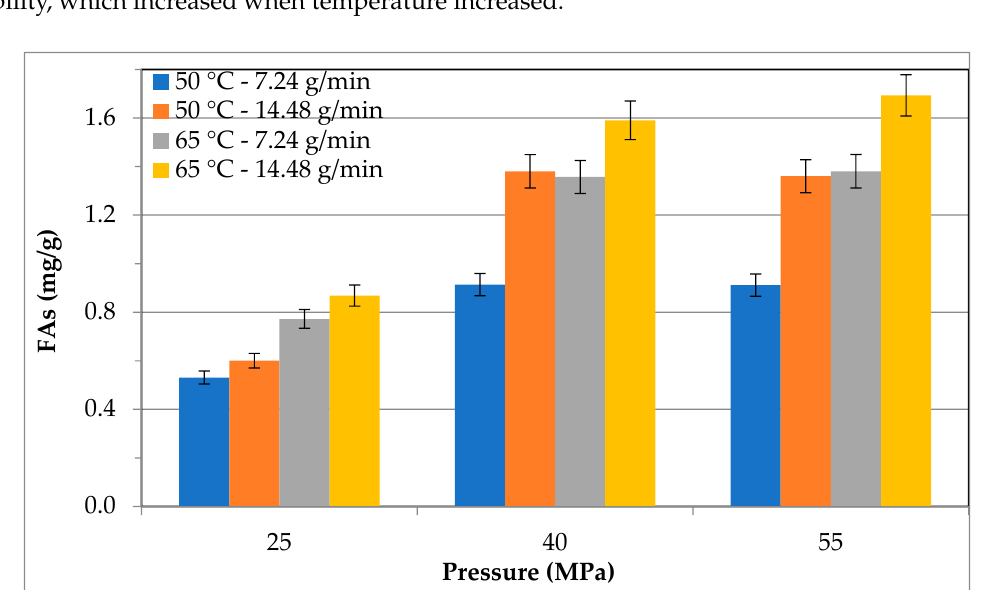
Table 2. Effect of SF-CO 2 operating conditions on fatty acids from S. almeriensis -pretreated biomass.